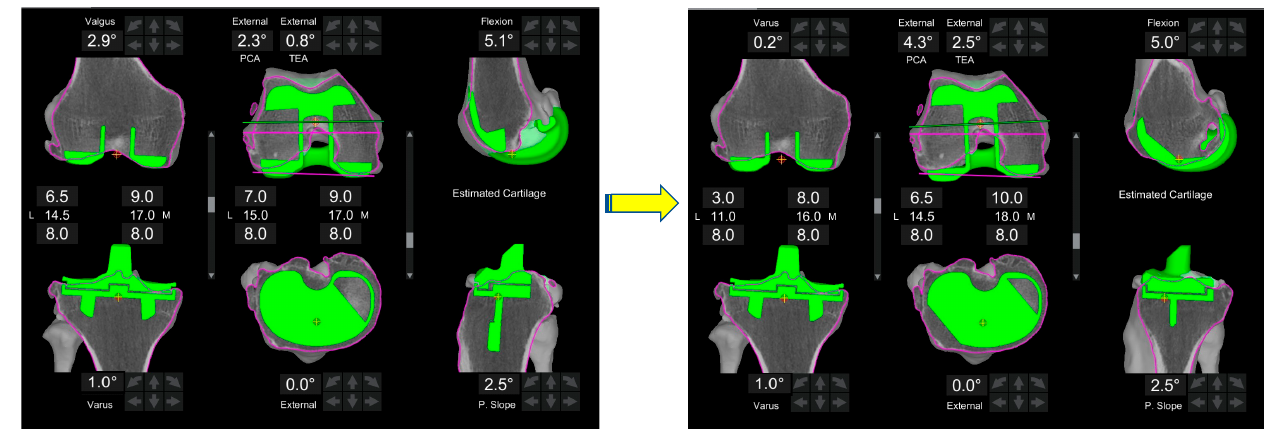
Figure 6. Functional alignment. The major difference between the FA and previous philosophies is the modification of alignment based on a combination of constitutional bony anatomy and soft-tissue laxity assessment. In this example, the plan (left image) is adapted within defined boundaries (right image) based on the patient’s soft tissue envelope in order to achieve balance targets.